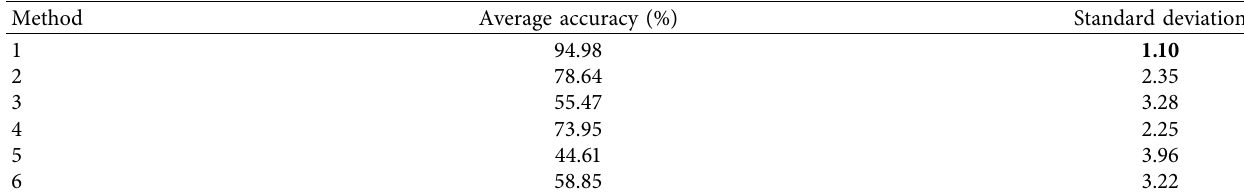
Table 3: The concrete classification accuracy and standard deviation per